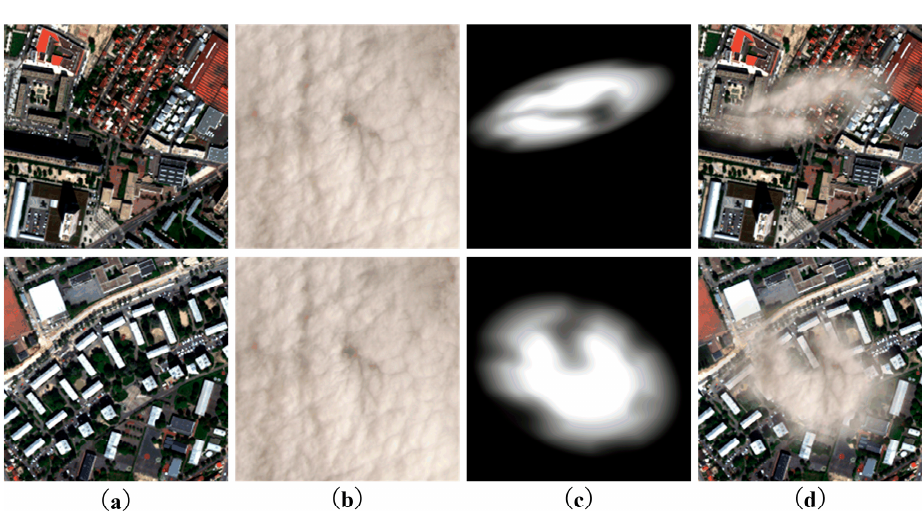
Figure 14. Samples from the Paris dataset. ( a ) Cloud-free images; ( b ) real cloud images; ( c ) cloud masks; ( d ) simulated cloud images.